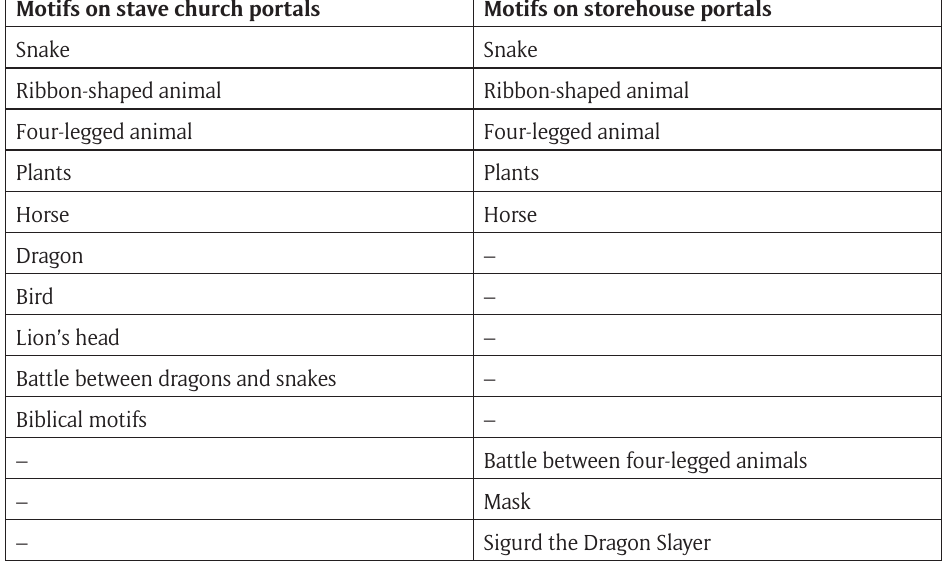
Table 4: Motifs on church portals compared with profane